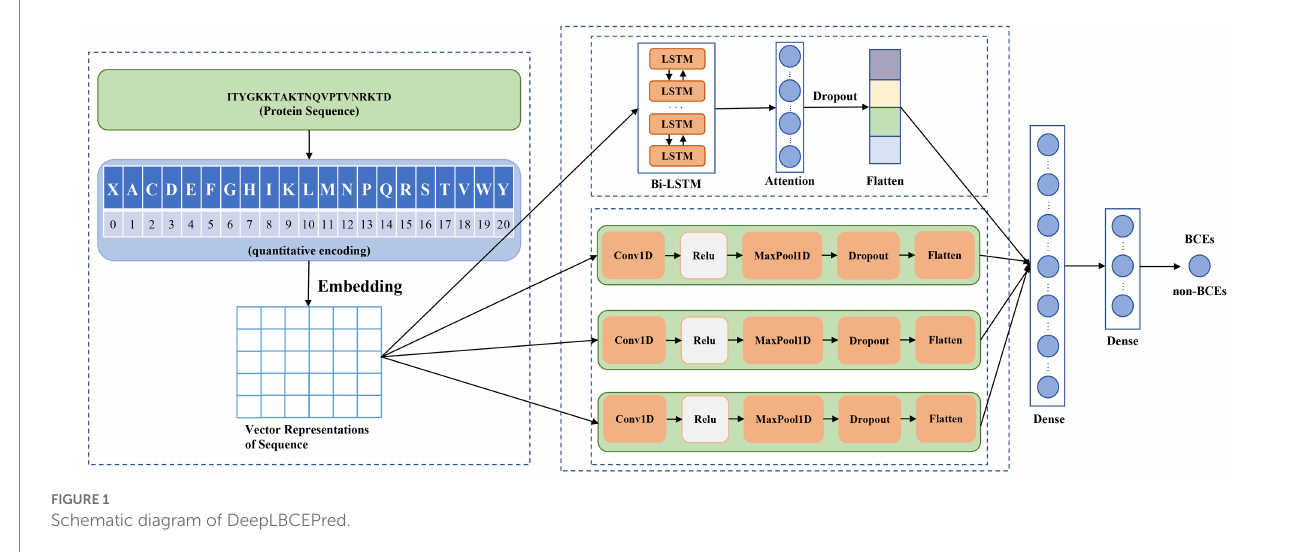
FIGURE 1 Schematic diagram of DeepLBCEPred.